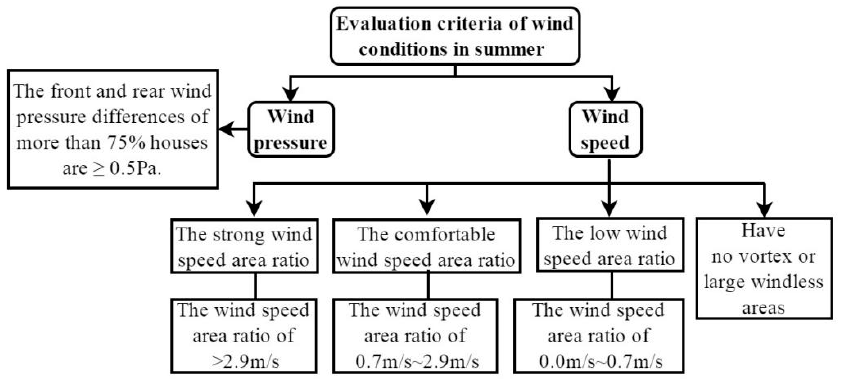
Figure 3. Diagram of the evaluation criteria for the outdoor wind environment.